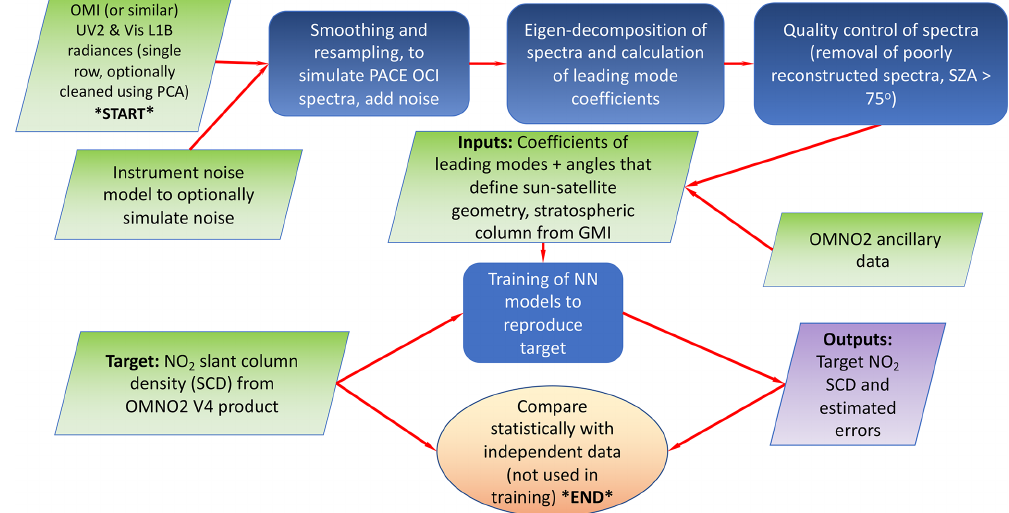
Figure 3. Data flow diagram showing the simulation of radiance for a low-spectral-resolution hyperspectral instrument (PACE OCI) using observations from a higher-spectral-resolution instrument (OMI) as well as training and evaluation of a neural network (NN) to estimate NO 2 slant column densities